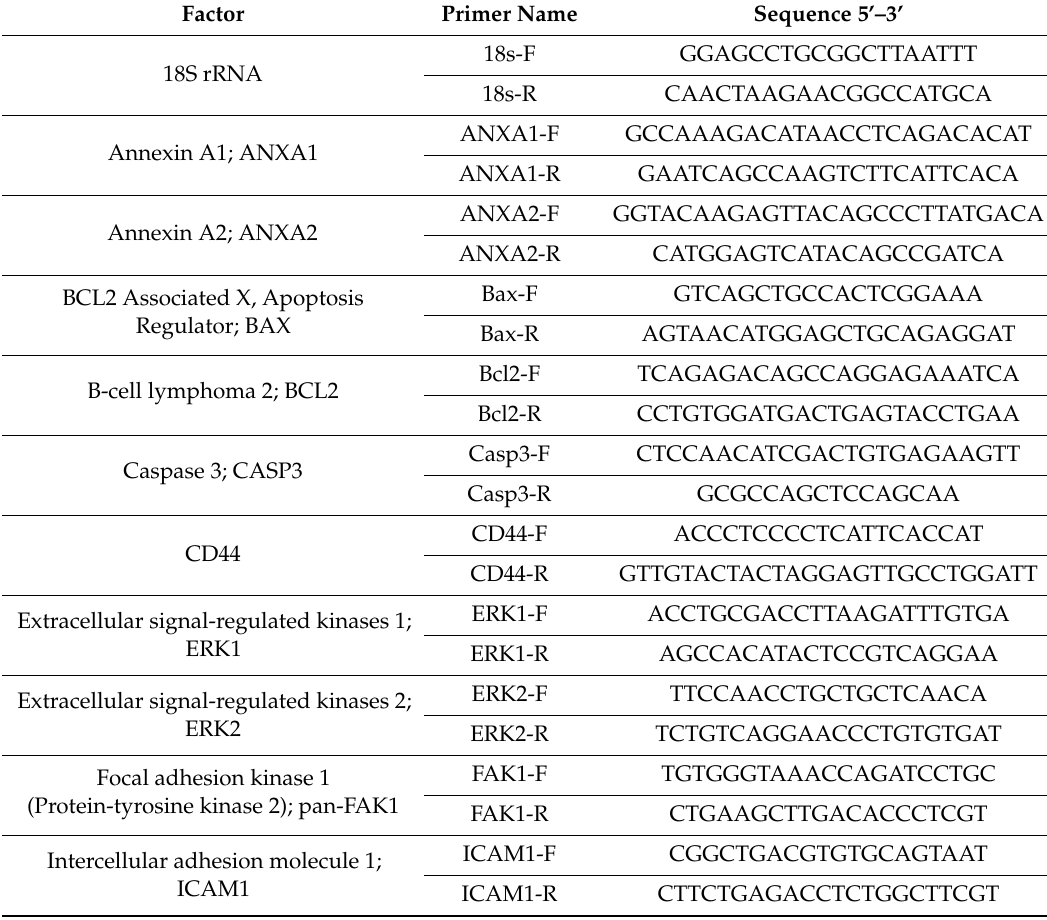
Table 1. List of primer used during the study. Primer sequences are given in 5 (cid:48) to 3 (cid:48) direction.